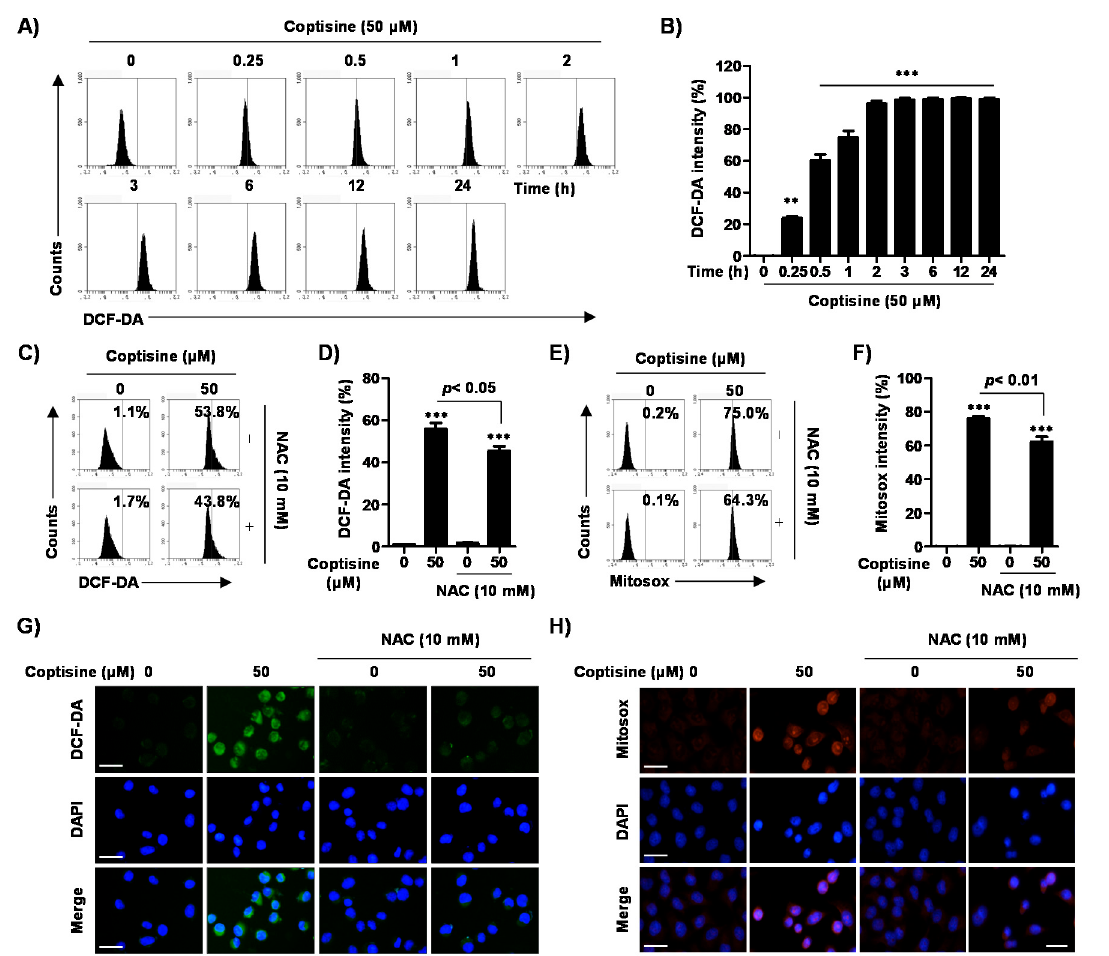
Figure 5. Increase of intracellular and mitochondrial reactive oxygen species (ROS) generation by coptisine in Hep3B cells. ( A , B ) The cells were treated with 50 µM coptisine for the indicated times. After staining with 10 µM 2 ′ ,7 ′ -dichlorofluorescein diacetate (DCF-DA) for 20 min, the fluorescent intensity was analyzed by flow cytometry. ( A ) depicts representative profiles. ( B ) shows the fluorescent intensity, indicated as the percentage of all the present cells. The data are expressed as the mean ± SD of three findings with independent experiments. ** p < 0.01 and *** p < 0.001 vs. control. ( C – H ) Cells were pretreated with or without 10 mM N -acetylcysteine (NAC), a ROS scavenger, for 1 h, followed by coptisine treatment for 30 min. After being probed with 10 µM DCF-DA ( C , D ) or 1 µM MitoSOX™ red for 20 min ( E , F ), the stained cells were observed by flow cytometry ( C – F ) and fluorescent microscopy ( G , H ). ( C , E ) depict representative results. In ( D , F ), each bar indicates fluorescent intensity for DCF-DA and MitoSOX™ red. In ( G , H ), representative fluorescent images. DAPI staining was used to visualize nuclei. Scale bars, 30 µm.